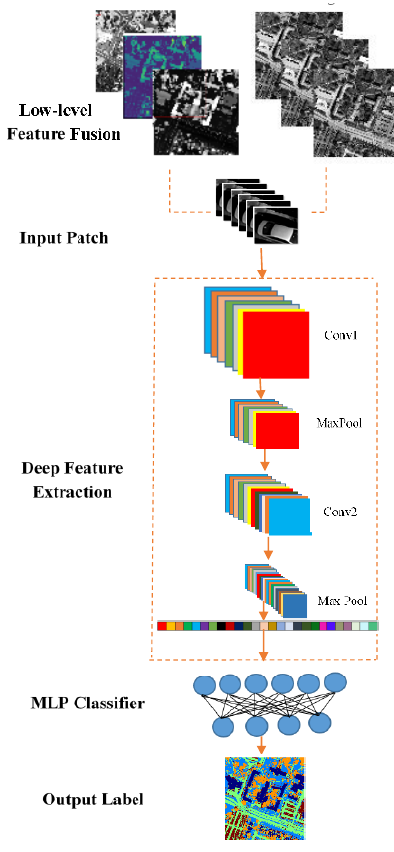
Figure 1. Framework of deep feature fusion for VHR and LiDAR data for accurate